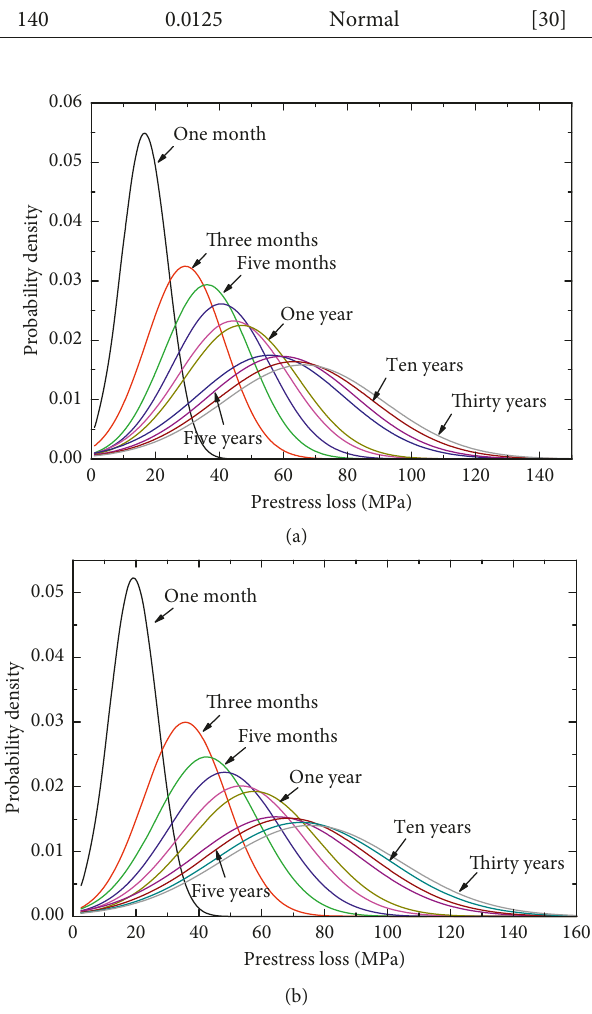
Figure 9: Time-varying PDFs of long-term loss. (a) PC1. (b)